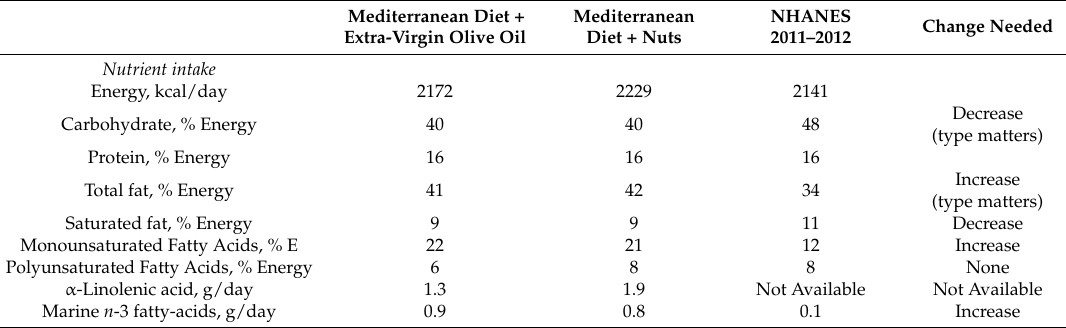
Table 2. Dietary pattern comparison of PREDIMED MedDiet groups and U.S. average